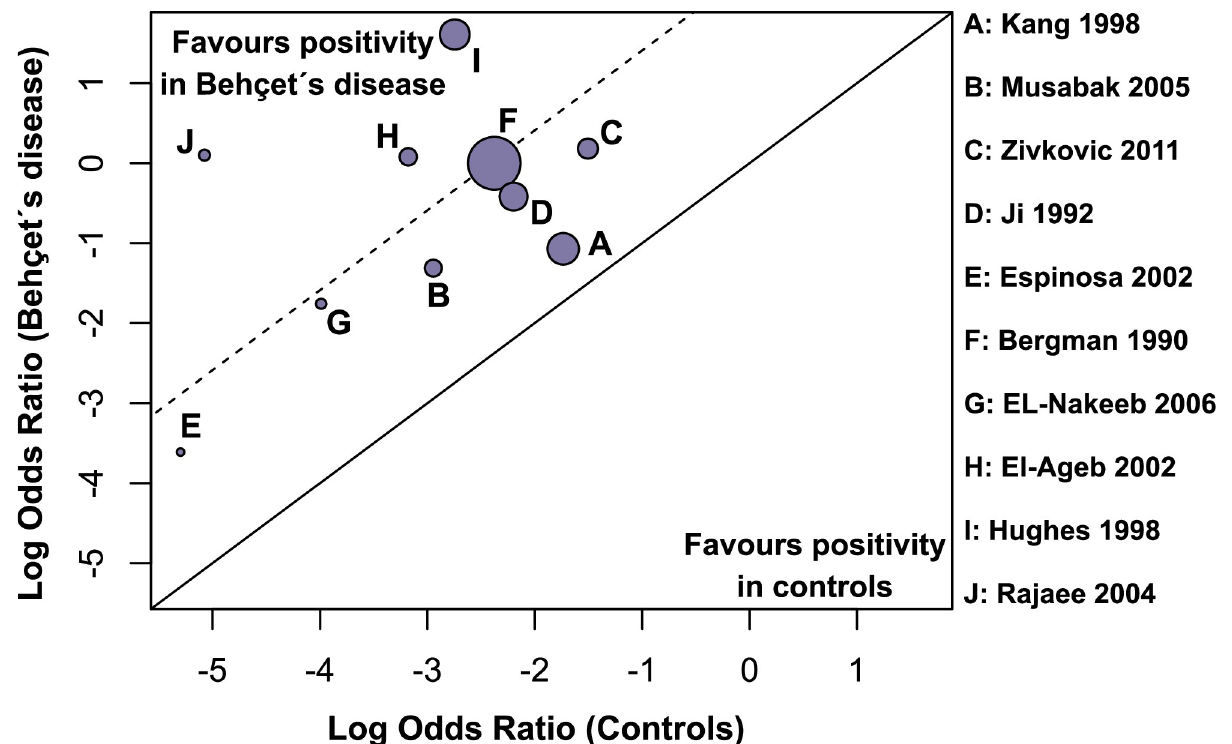
Fig 4. L’Abbe´ plot for the prevalence of aCL antibodies in Behc¸et’s disease and controls suggests no substantial heterogeneity.